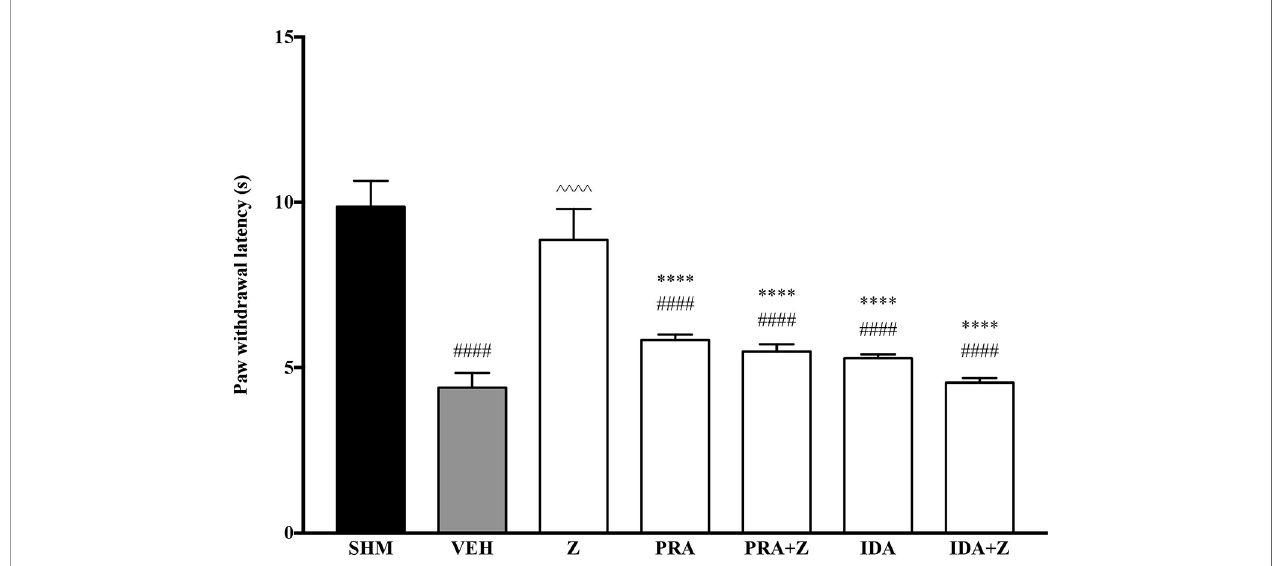
FIGURE 4 | Effect of prazosin ( a 1 -adrenoceptor antagonist) and idazoxan ( a 2 -adrenoceptor antagonist) pre-treatment on zerumbone against thermal hyperalgesia in CCI-induced neuropathic pain mice. Data are presented as mean ± SEM (n = 6). #### p < 0.0001 as compared to sham, ^^^^ p < 0.0001 as compared to vehicle and **** p < 0.0001 as compared to zerumbone-treated group. SHM (Sham); VEH (Vehicle, 10 mL/kg i.p.); Z (Zerumbone, 10 mg/kg i.p.); PRA (Prazosin, 10 mg/kg i.p.); IDA (Idazoxan, 2 mg/kg